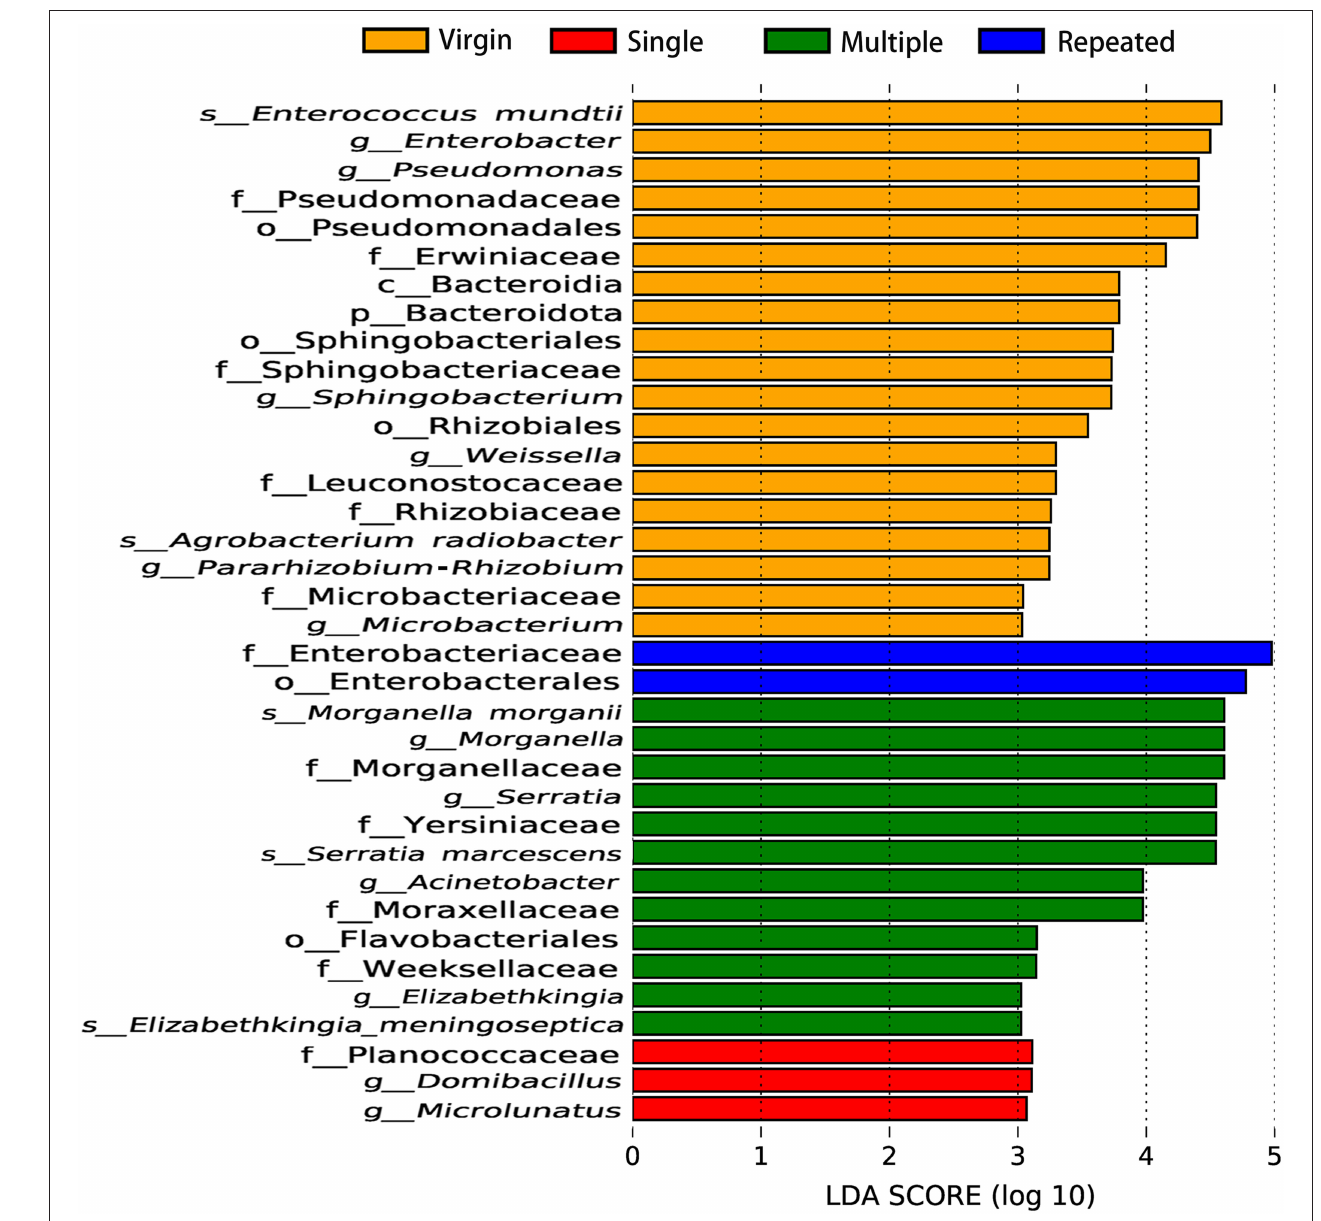
FIGURE 6 | Important biomarkers of bacterial communities in S. frugiperda females of different mating types revealed by linear discriminant analysis